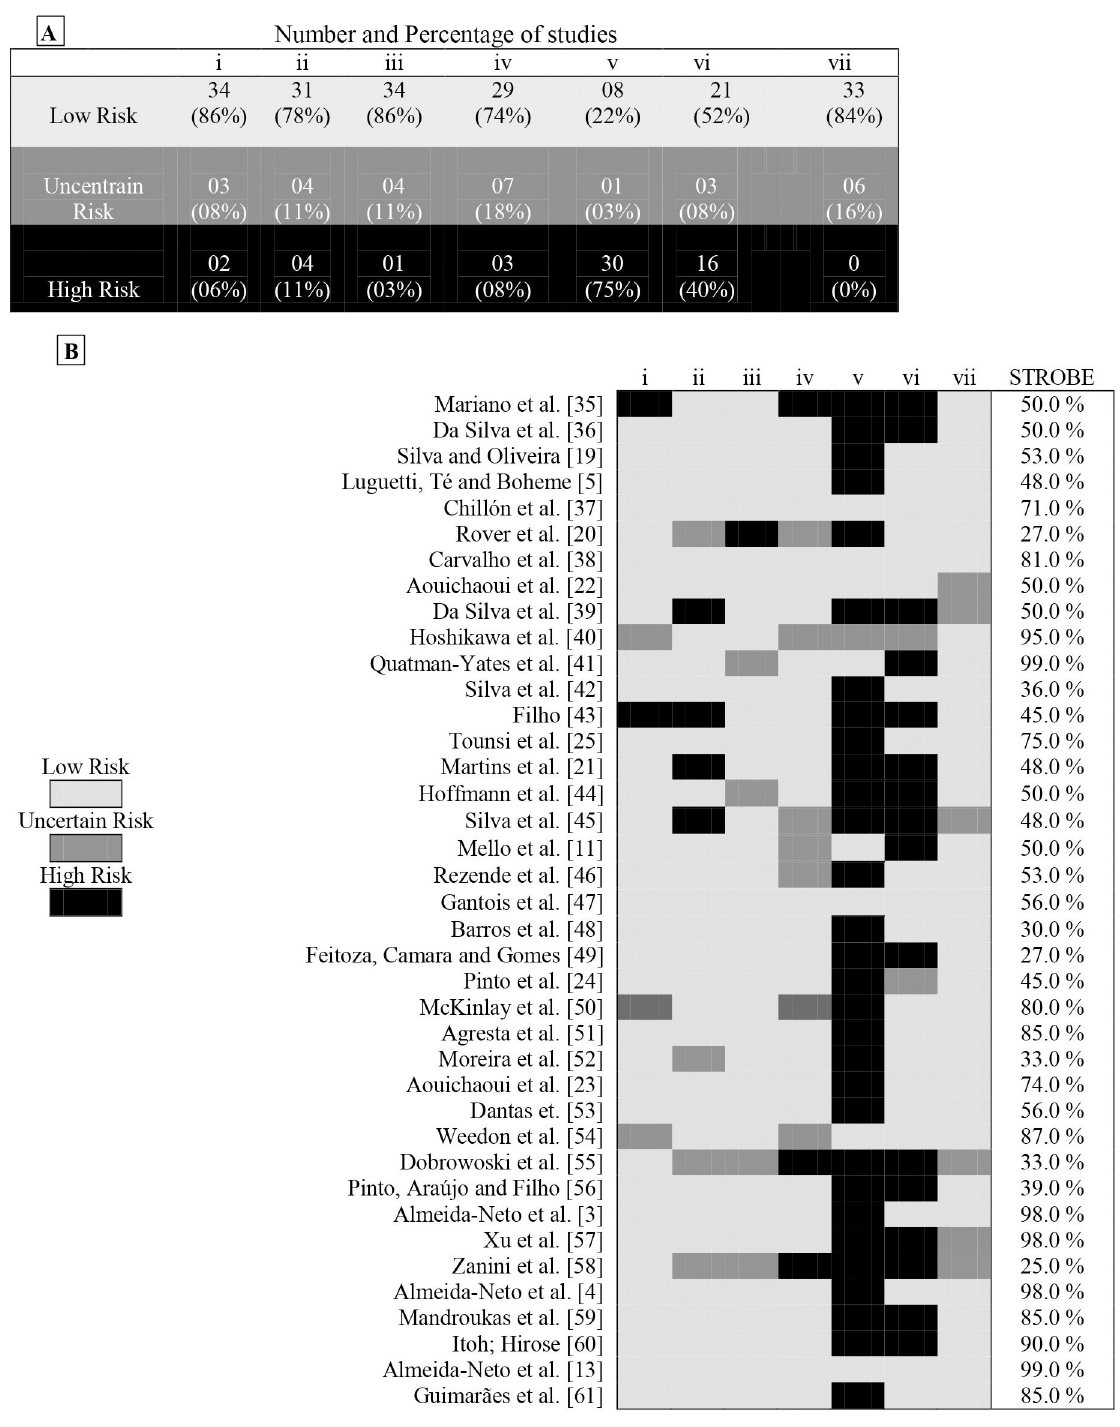
Fig 6. Graphical representation of bias analysis and of analysis of the components of the chekin linst STROBE. i: The study does not answer the research question adequately. ii: The sample base and the sample size were not adequate. iii: Objective, adequate and standardized criteria for the outcome were not used. iv: The outcome was measured in a skewed manner. v: Results are not given with a confidence interval when appropriate. vi: The study does not expose practical applicability. vii: The study has no reproducibility for other samples from different populations. STROBE—Percentage of minimum requirements met for observational